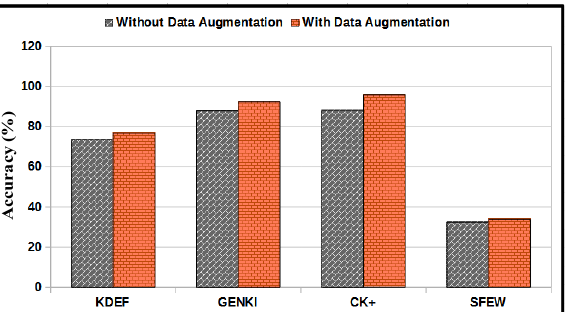
Figure 13. Effect on the performance of the proposed FERS using proposed data augmenta- tion